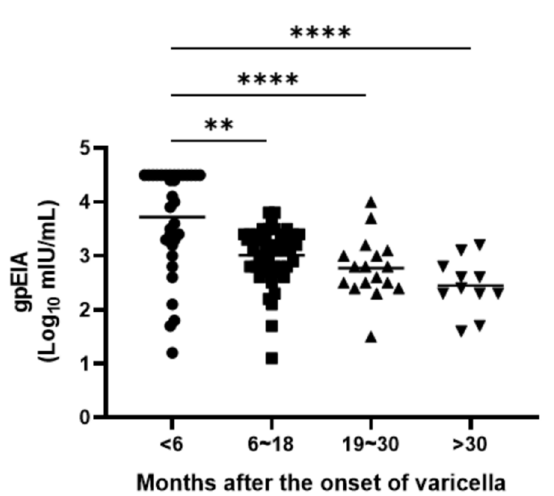
Figure 3. gpEIA titers of 109 vaccinees with varicella history according to the time elapsed from varicella disease. The p values were calculated using Kruskal–Wallis test using Tukey’s multiple comparisons test. ** p < 0.01, **** p < 0.0001.